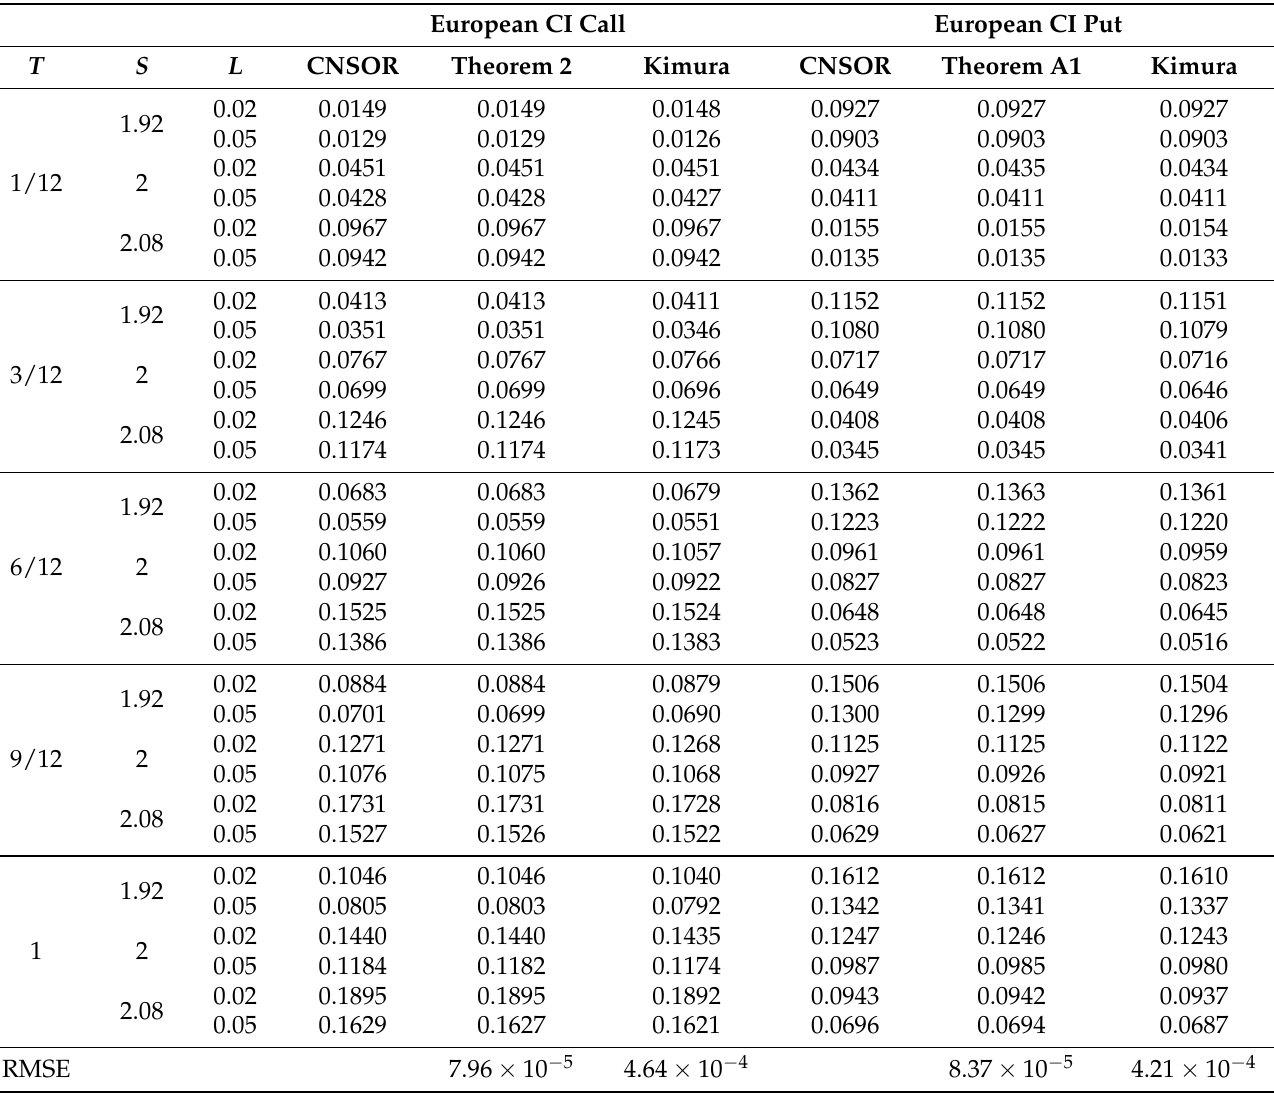
Table 1. Comparison of European CI call and put option prices using CNSOR, Theorem 2, Theorem A1 and Kimura’s result in [8]. Parameters used: X = 2, r = 0.05, q = 0.04, σ =